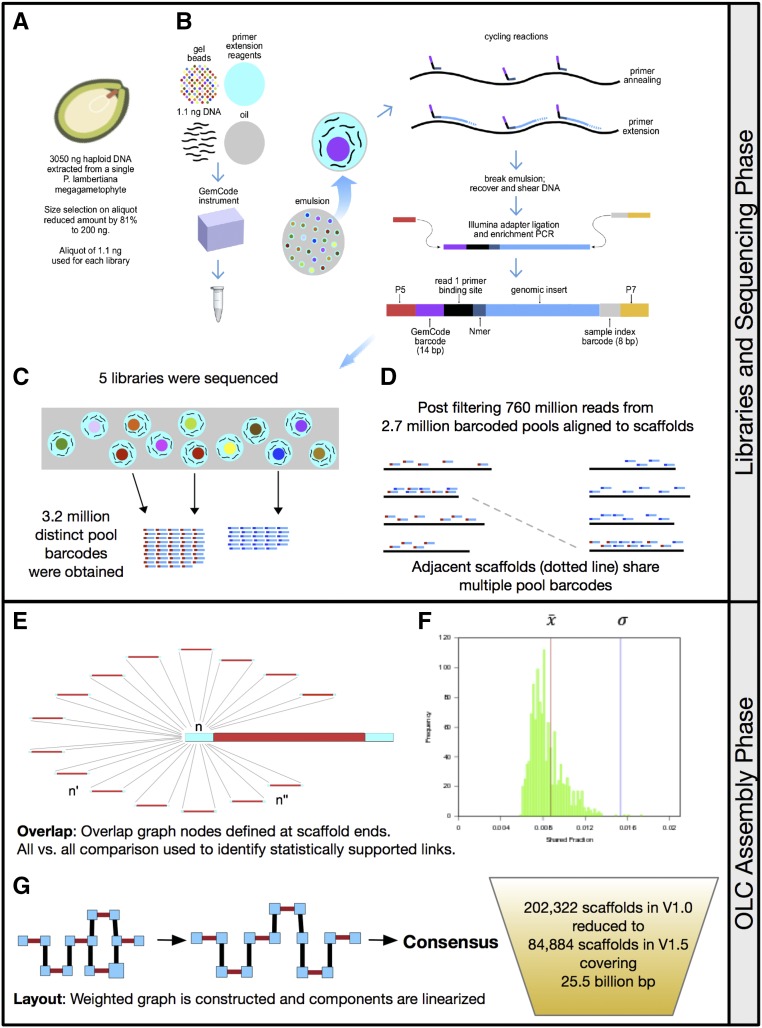
(Top) Construction of synthetic long read clouds with 10× Genomics technology. (A) HMW DNA is prepared from a single haploid sugar pine MGP. (B) Within the instrument emulsion droplets are used to pool HMW DNA. A barcode containing bead in each droplet is used for indexing the pools. During subsequent thermal cycling the bead dissolves and the input DNA fragments act as templates for primer extension by the barcoded random hexamers (blue). All extension products within a droplet contain the same 14 bp barcode (magenta). After completion of primer extension cycles the emulsion is “broken,” pooled extension products are physically sheared to subkilobase fragments, and p7 and p5 adapters are added to the barcoded terminal fragments by ligation and enrichment PCR. Final molecules have the standard configuration and adapter sequences of Illumina dual-index, paired-end libraries, except that i5 is 14 bp instead of 8 bp. The random hexamer sequence (Nmer) is trimmed from the start of read one during data processing. (C) The oligo-containing gel bead (colored dots) within each droplet contains a single 14 bp barcode and multiple long DNA fragments (wavy lines) that serve as templates for generation of library fragments and then reads (short bicolored bars). Different droplets may contain identical gel beads increasing the effective size of the pool. All reads with the same barcode form an effective pool. (D) Alignments to a contig will assign the contig to one or more pools. Overlap graph nodes are defined in windows at the contig ends. Because there are a large number of distinct pools (barcodes), any two nodes are unlikely to belong to the same two (or more) pools by chance. However, one shared barcode is common. (Bottom) Scaffolding with synthetic long read clouds and fragScaff. (E) For each node, the read group assignments for that node are compared with the read group assignments for every other node and the fraction of read groups shared between them (their “shared fraction”) is calculated. (F) A typical distribution of shared fraction for a node in our data. For each node, a normal distribution is fitted to the observed shared fraction data. Link scores for each ordered pair of nodes are computed by taking the negative log10 probability of the observed shared fraction under the fitted normal distribution. After all pairwise link scores are calculated, a global link score threshold is determined. In our example, the pair (n, n′) shared one barcode and are below the threshold, while the pair (n, n′′) shared >1 and are above. (F) Pairs of nodes with a score exceeding the global link score threshold become edges in an overlap graph with a weight corresponding to the score. (G) Layout linearizes the weighted graph and is accomplished by greedy algorithm described in (Adey et al. 2014). From each linearized subgraph the consensus scaffold is determined by concatenating component scaffolds.